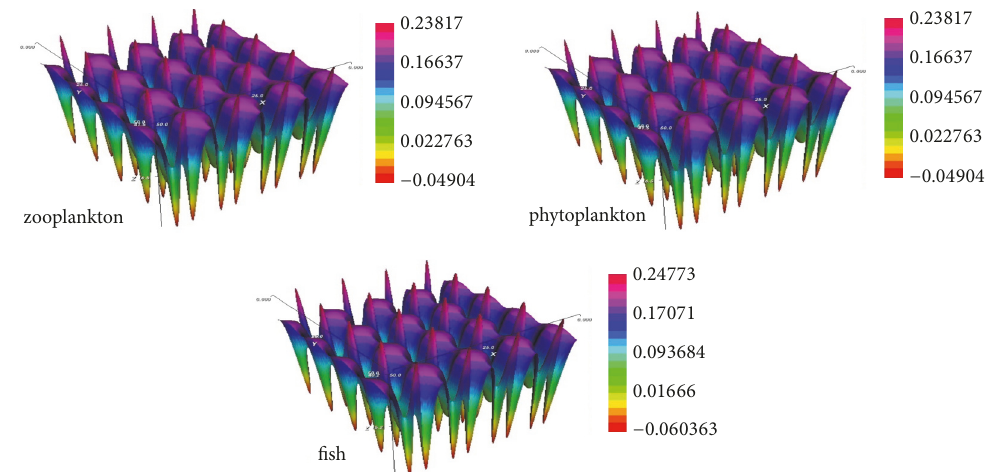
Figure 8: Dynamics behavior for 𝜃 𝑝 = 0.18 .